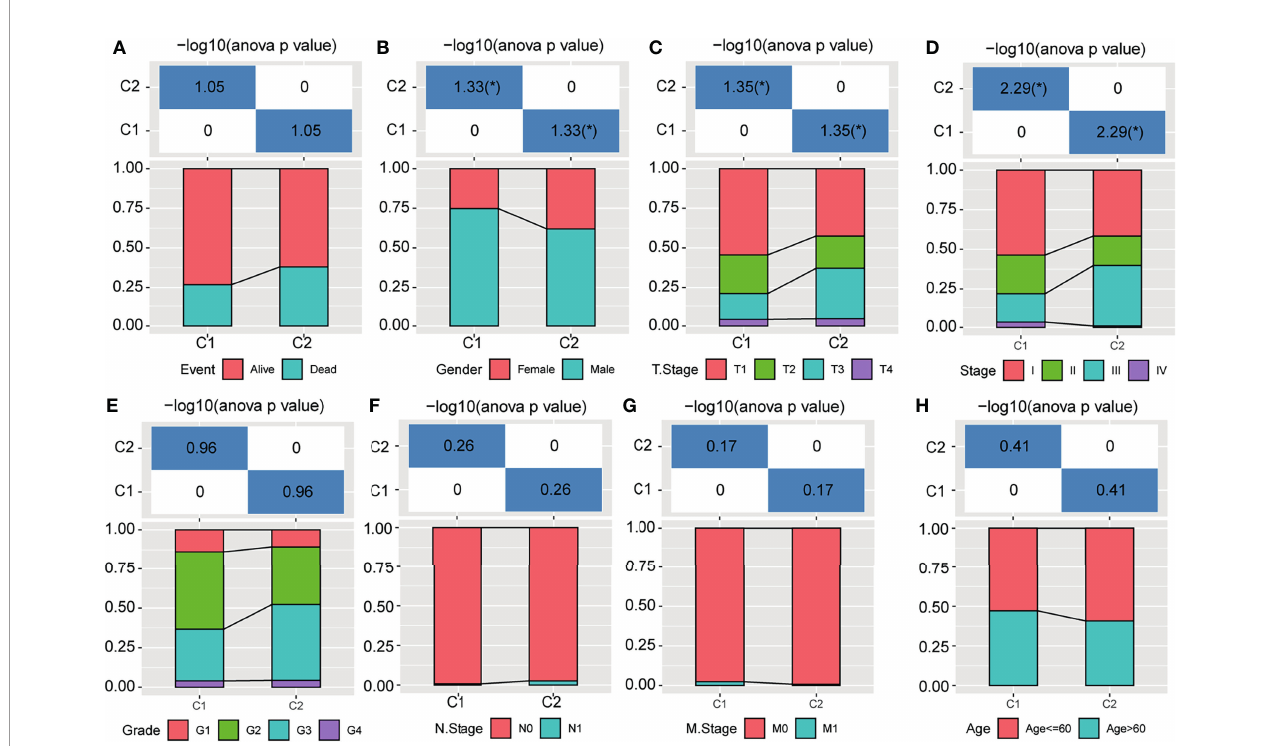
FIGURE 3 | Distribution of m1A-related subtypes in clinical features. (A – H) The survival status, sex, T stage, stage, grade, N stage, M stage, and age of the m1A- modi fi ed subtypes. *P <